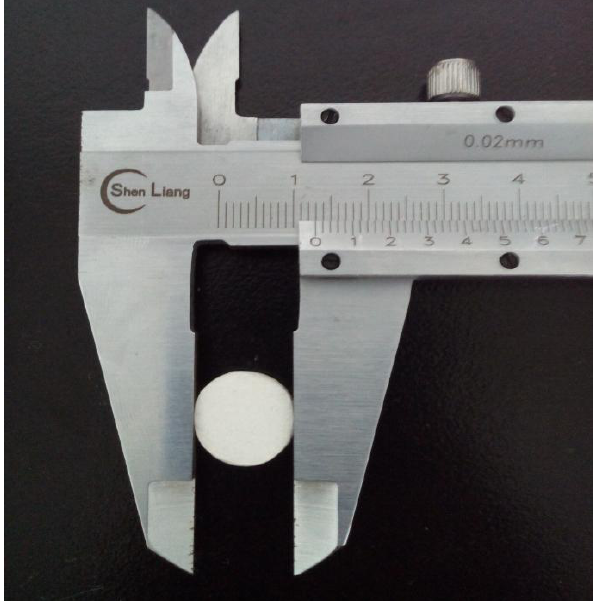
Figure 2. Optical digital photo of the porous sponge.